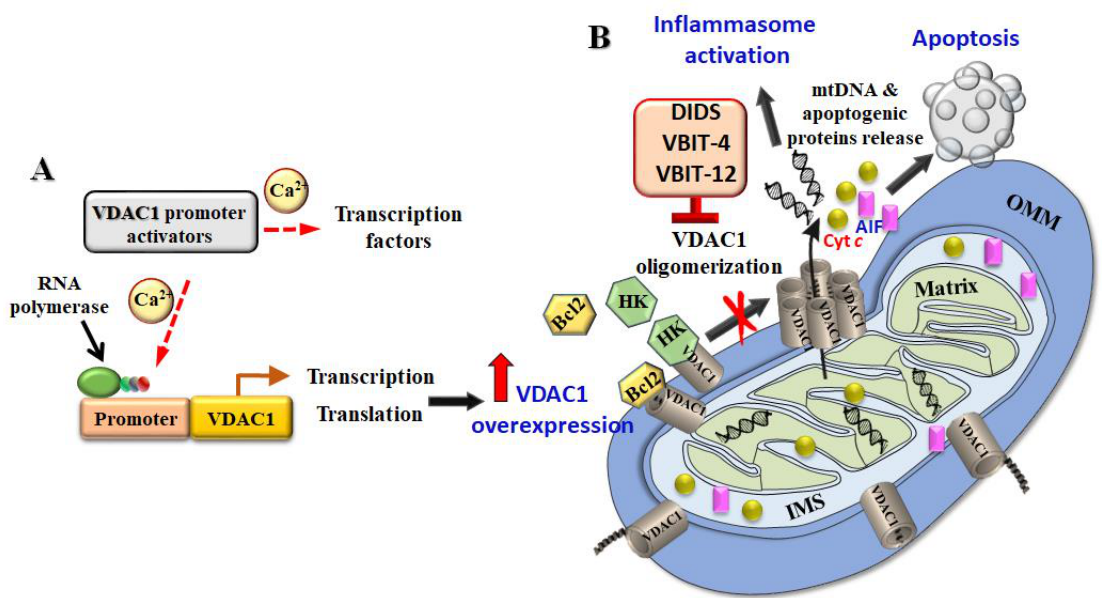
Figure 3. Proposed model for the mechanism of action for activators of the VDAC1 promoter leading oligomerization, and apoptosis. ( A ) Apoptotic stimuli act either by directly activating the VDAC1 promoter or by stimulating the activity of TFs, thereby inducing VDAC1. Ca 2+ directly or via a TF leads to promoter activation. ( B ) Overexpressed VDAC1 shifts the equilibrium to the VDAC1 oligomeric state, mediating the release of apoptogenic proteins, and leading to apoptosis. VDAC1-interacting molecules such as VBIT-4, inhibit VDAC1 oligomerization and apoptosis.